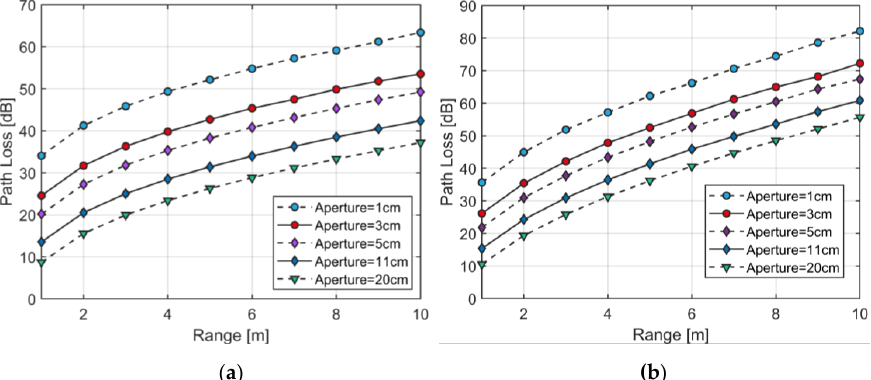
Figure 10. Path loss for different ranges with different apertures ( a ) coastal water, ( b ) turbid harbor water.